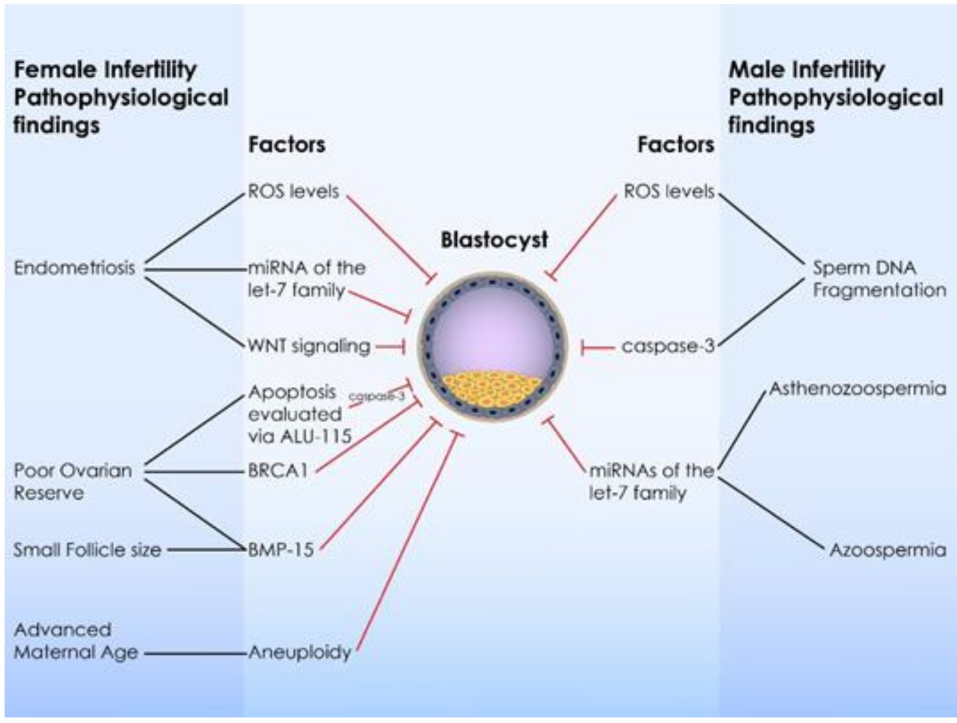
Figure 2. Infertility pathophysiologies and factors leading to developmental arrest of the human preimplantation